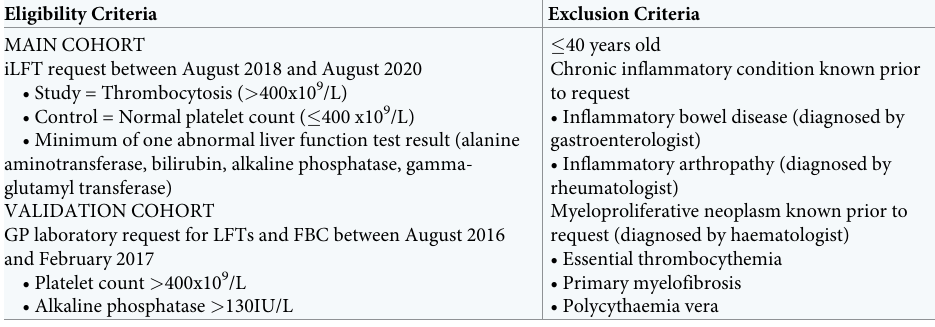
Table 1. Eligibility and exclusion criteria of main cohort including study and control